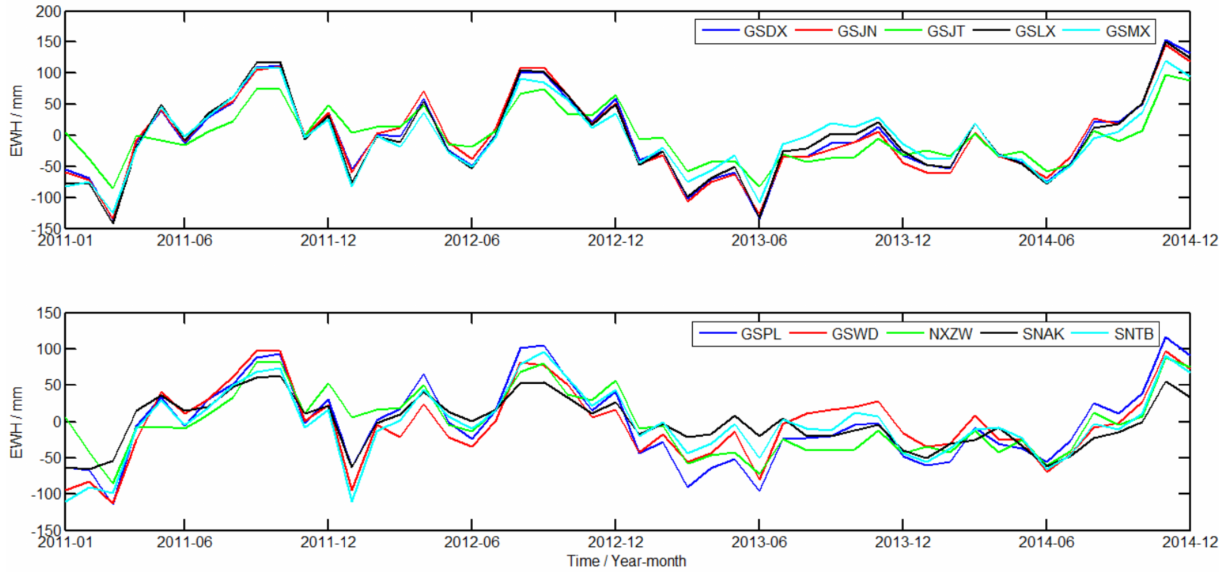
Figure 7. Time series of GWS changes at ten CORS stations derived from GNSS